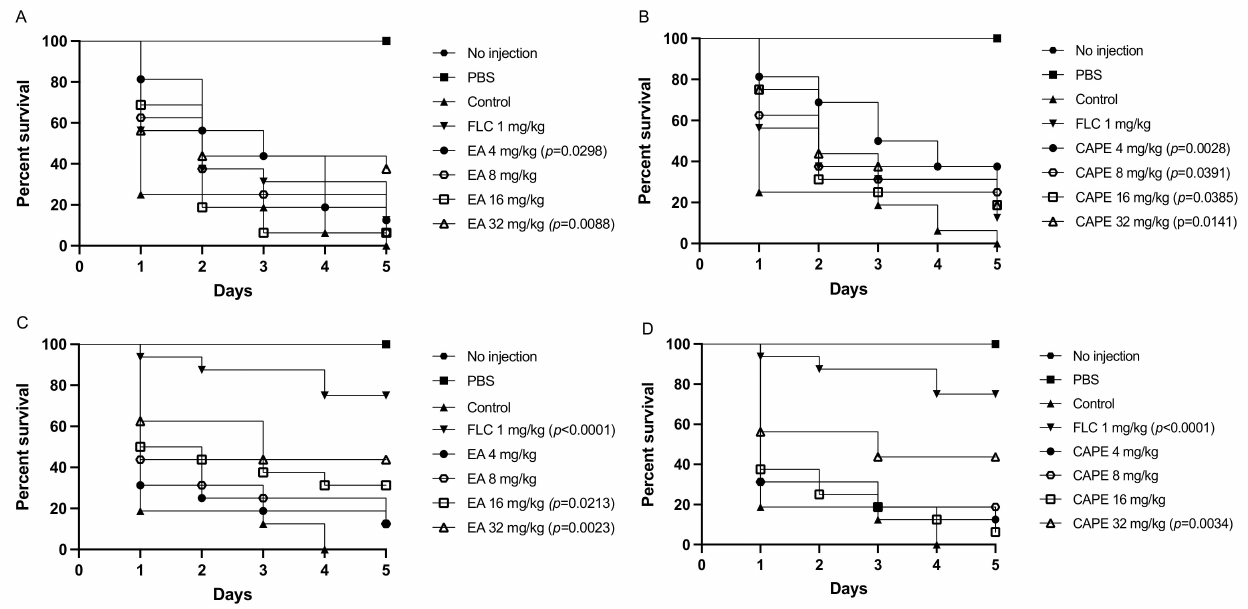
Figure 7. Kaplan–Meier survival curves of infected G. mellonella larva. ( A , B ) Survival of G. mellonella larvae infected with C. auris and treated with different doses of EA or CAPE, respectively, 2 h prior the infection. ( C , D ) Survival of G. mellonella larvae infected with C. albicans and treated with different doses of EA or CAPE, respectively, 2 h prior the